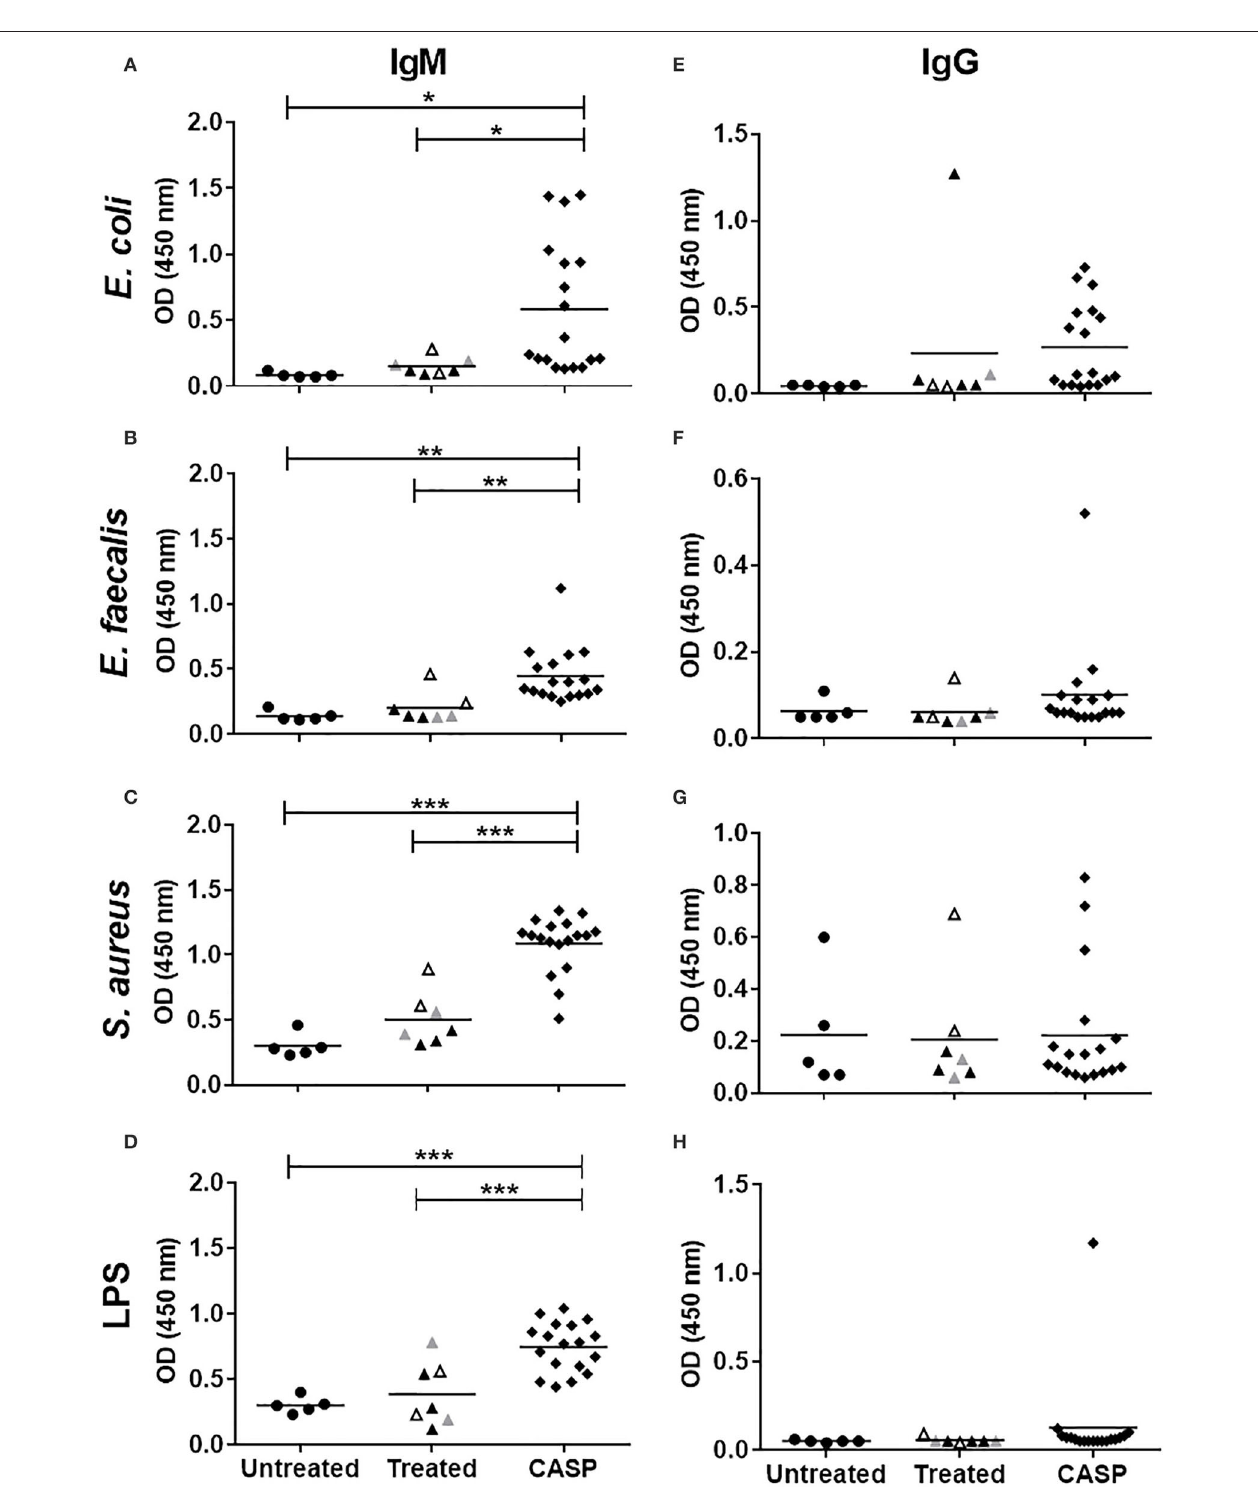
FIGURE 1 | Binding of sera IgM/IgG to bacteria and LPS. The binding of murine serum antibodies, IgM (A-D) or IgG (E-H), to indicated bacteria; E. coli (A,C) , E. faecalis (B,F) , S. aureus (C,G) , and LPS (D,H) was tested by ELISA. Fourteen days after sepsis induction, blood was collected, and sera were diluted 1:100 in blocking buffer. Sera from non-septic animals were used as controls. Control mice were untreated (•), whereas the treated mice were anesthetized only ( N ), or additionally received a laparotomy ( ), or sham surgery ( △ ). Mice that underwent CASP surgery are indicated by a black diamond ( (cid:7) ). Mean values of OD 450nm are shown. Each symbol represents one animal ( N = 5–18). Statistical analysis was done by One-way ANOVA with the Bonferroni post test for selected pairs. * p < 0.05, ** p < 0.01, *** p < 0.001.